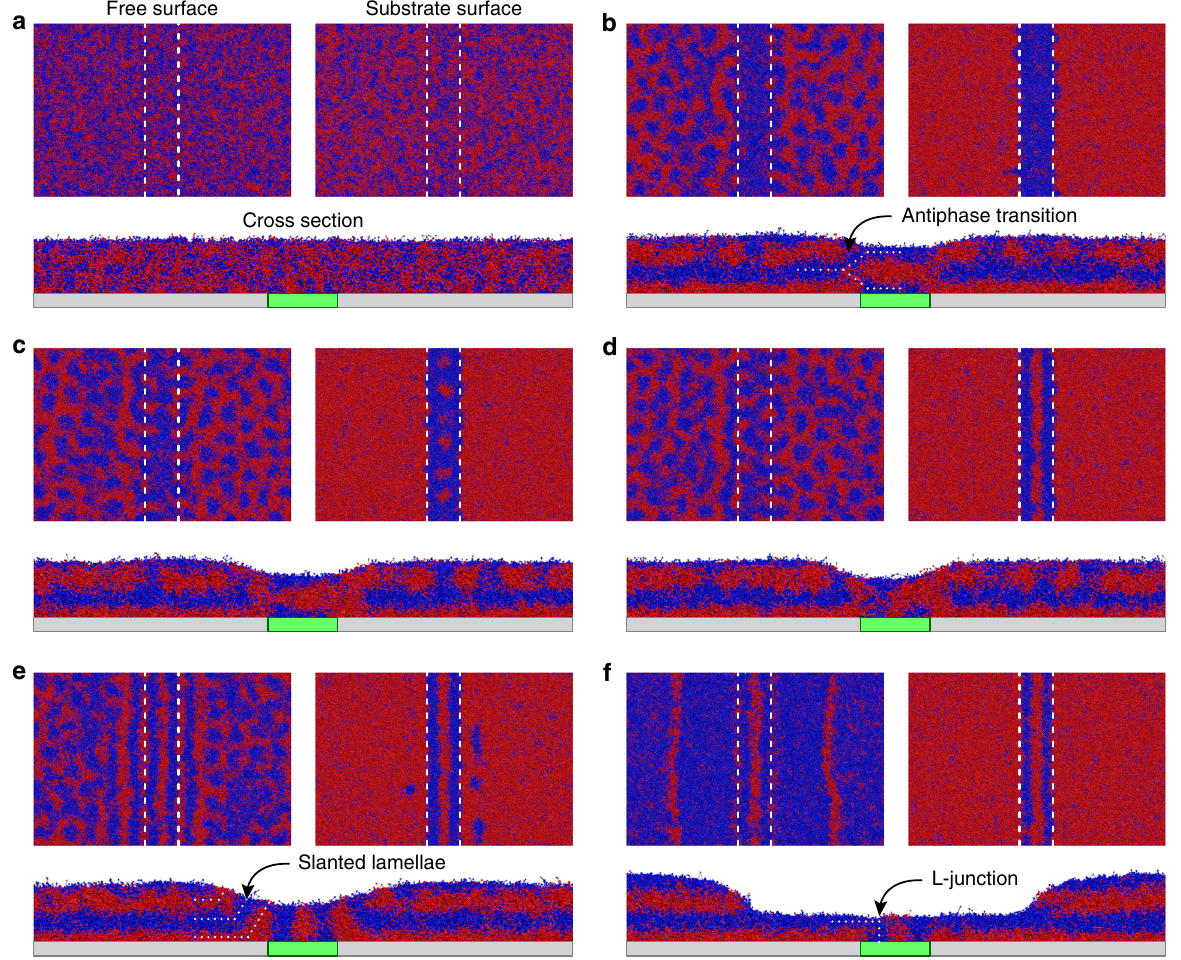
Fig. 5 Monte Carlo simulations. Simulated BCP morphology at the free (top) surface (top left), at the substrate (bottom) surface (top right), and along a cross-section perpendicular to the stripe width (bottom) after 10 2 ( a ), 6. 5 × 10 4 ( b ), 1.25 × 10 5 ( c ), 1.8 × 10 5 ( d ), 3.0 × 10 5 ( e ), and 2.15 × 10 6 ( f ) MC cycles. The stripe, substrate, B block, and A block are green, gray, blue, and red, respectively. White dashed lines indicate the positions of the stripe/substrate boundaries. White dotted lines in b , e , f highlight an antiphase transition between horizontal lamellae, a set of slanted lamellae, and an L-junction, respectively. Since vertical B lamellae and horizontal B lamellae connect via L-junctions along the stripe edge at the free surface, it is dif fi cult to differentiate these two domains in the top view in f . In contrast, in SEM images of the free surface (e.g., Figs. 1 – 3), vertical PS lamellae on the stripe display different contrast than horizontal PS lamellae on the substrate because the former domains are through- fi lm while the latter domains are on top of at least one horizontal PPC